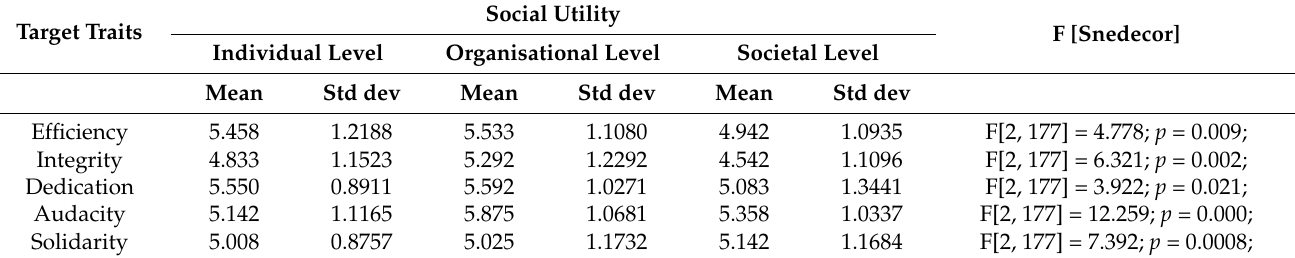
Table 5. Means and effects of context on social